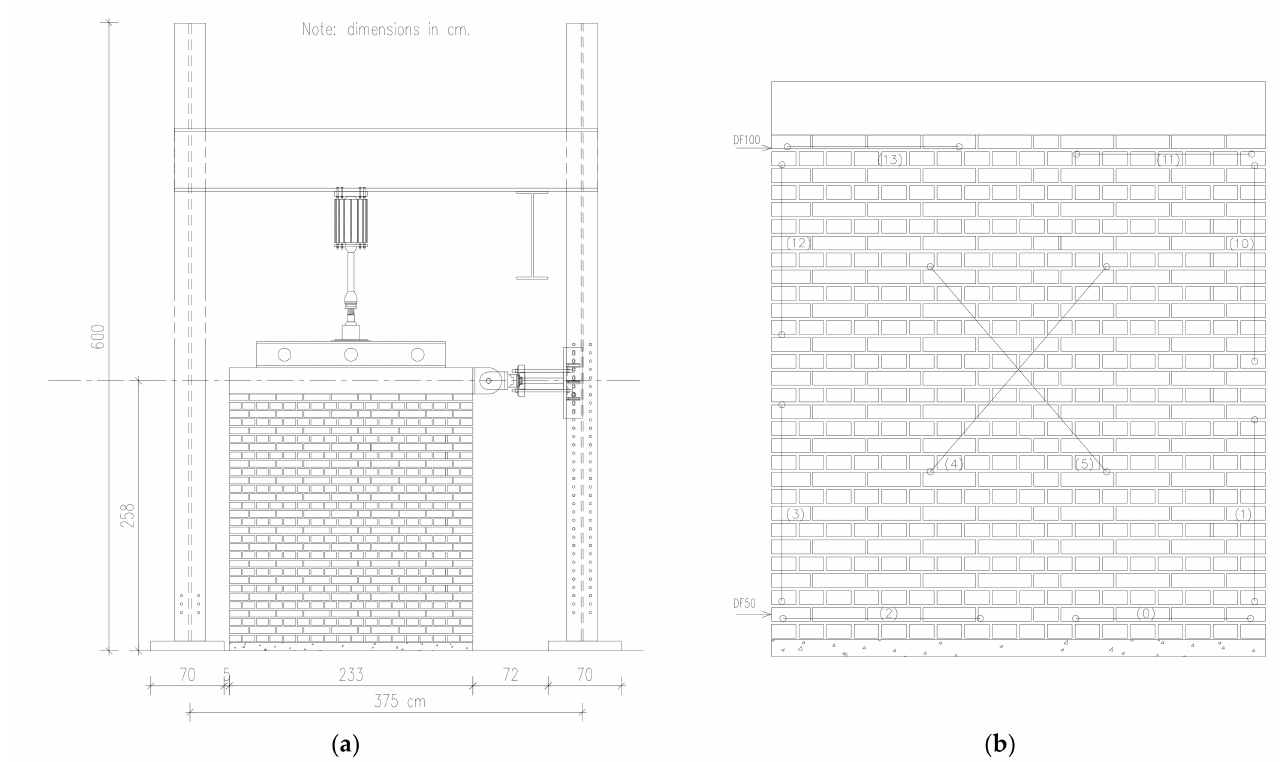
Figure 7. Masonry wall test set-up: ( a ) structural model; ( b ) layout of LVDTs.